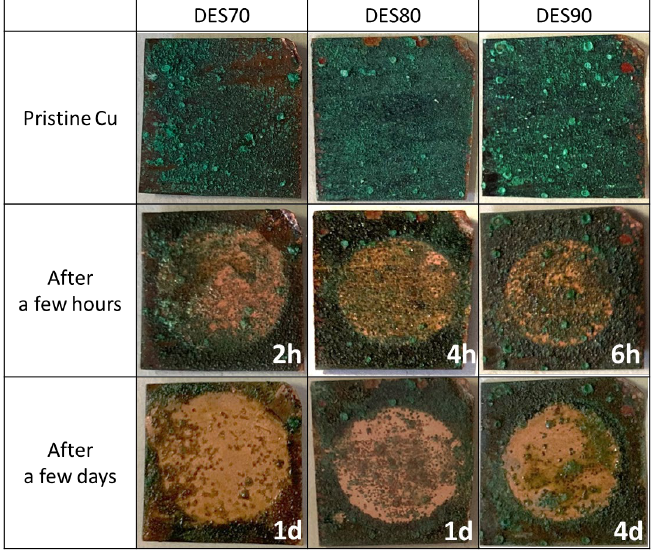
Figure 3. Photos of corroded copper sheets before and after cleaning with cellulose membranes (diameter was 1 cm) containing DES70, DES80, and DES90.